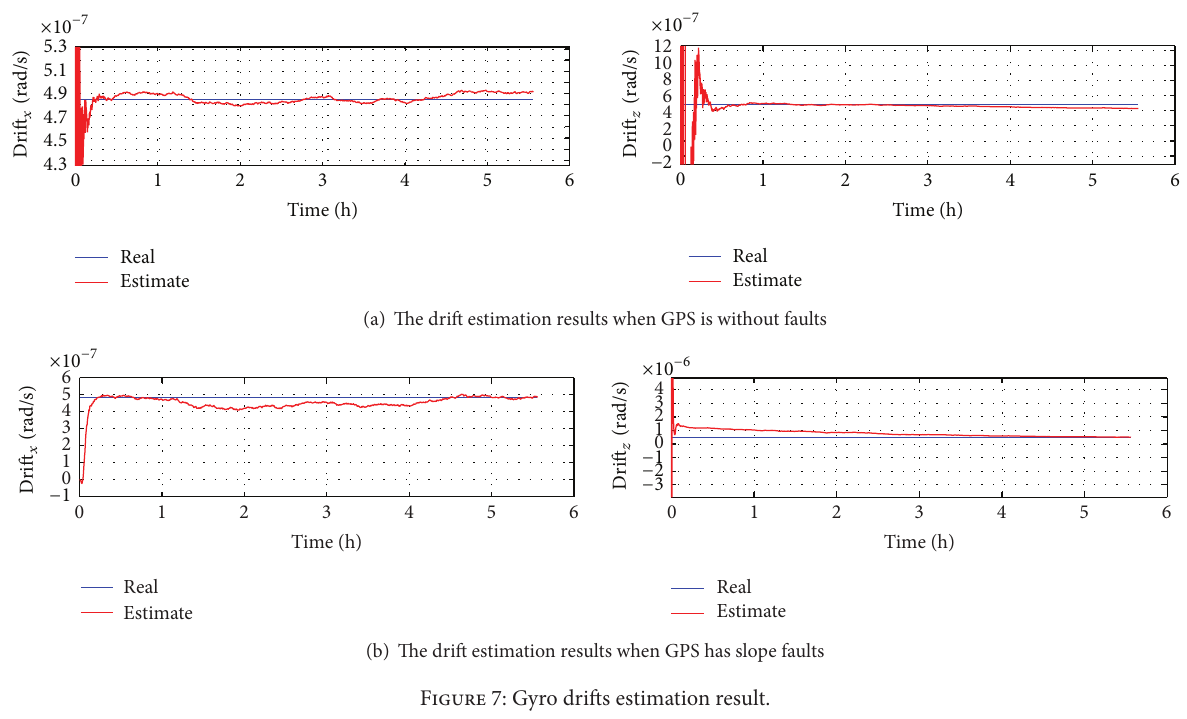
Figure 7: Gyro drifts estimation